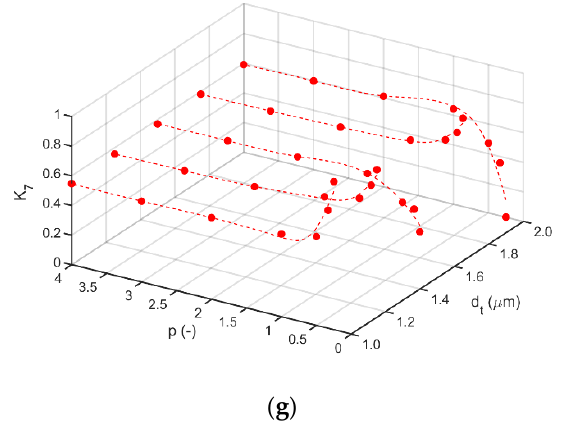
Figure 7. Dependences of K 1 ‒ K 7 ( a ‒ g ) on values of parameter p and thickness of gradient layer ( d t ).